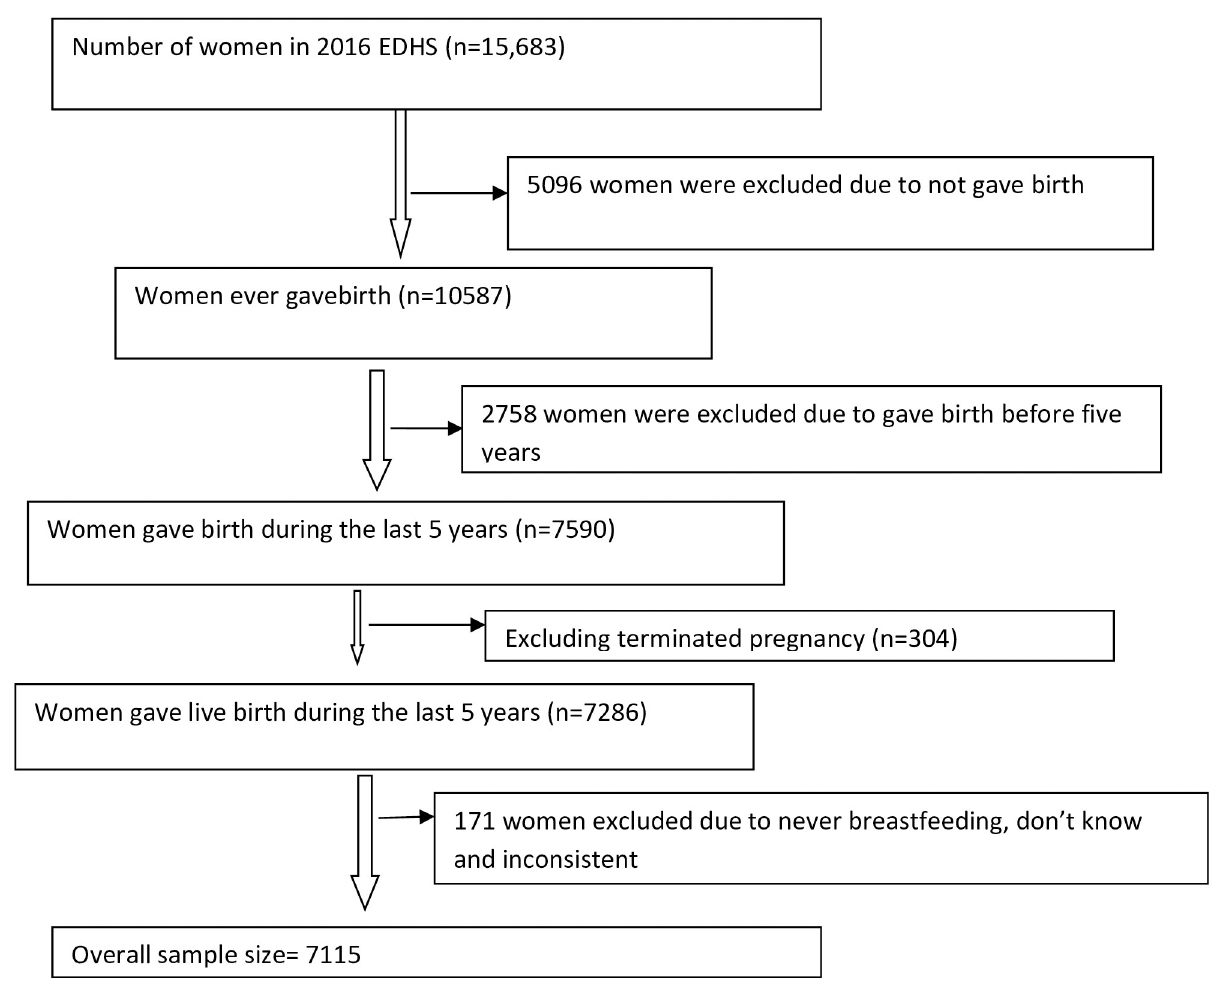
Fig 1. Schematic presentation showing sampling procedure in the 2016 Ethiopia Demographic and Health Surveys (EDHS);